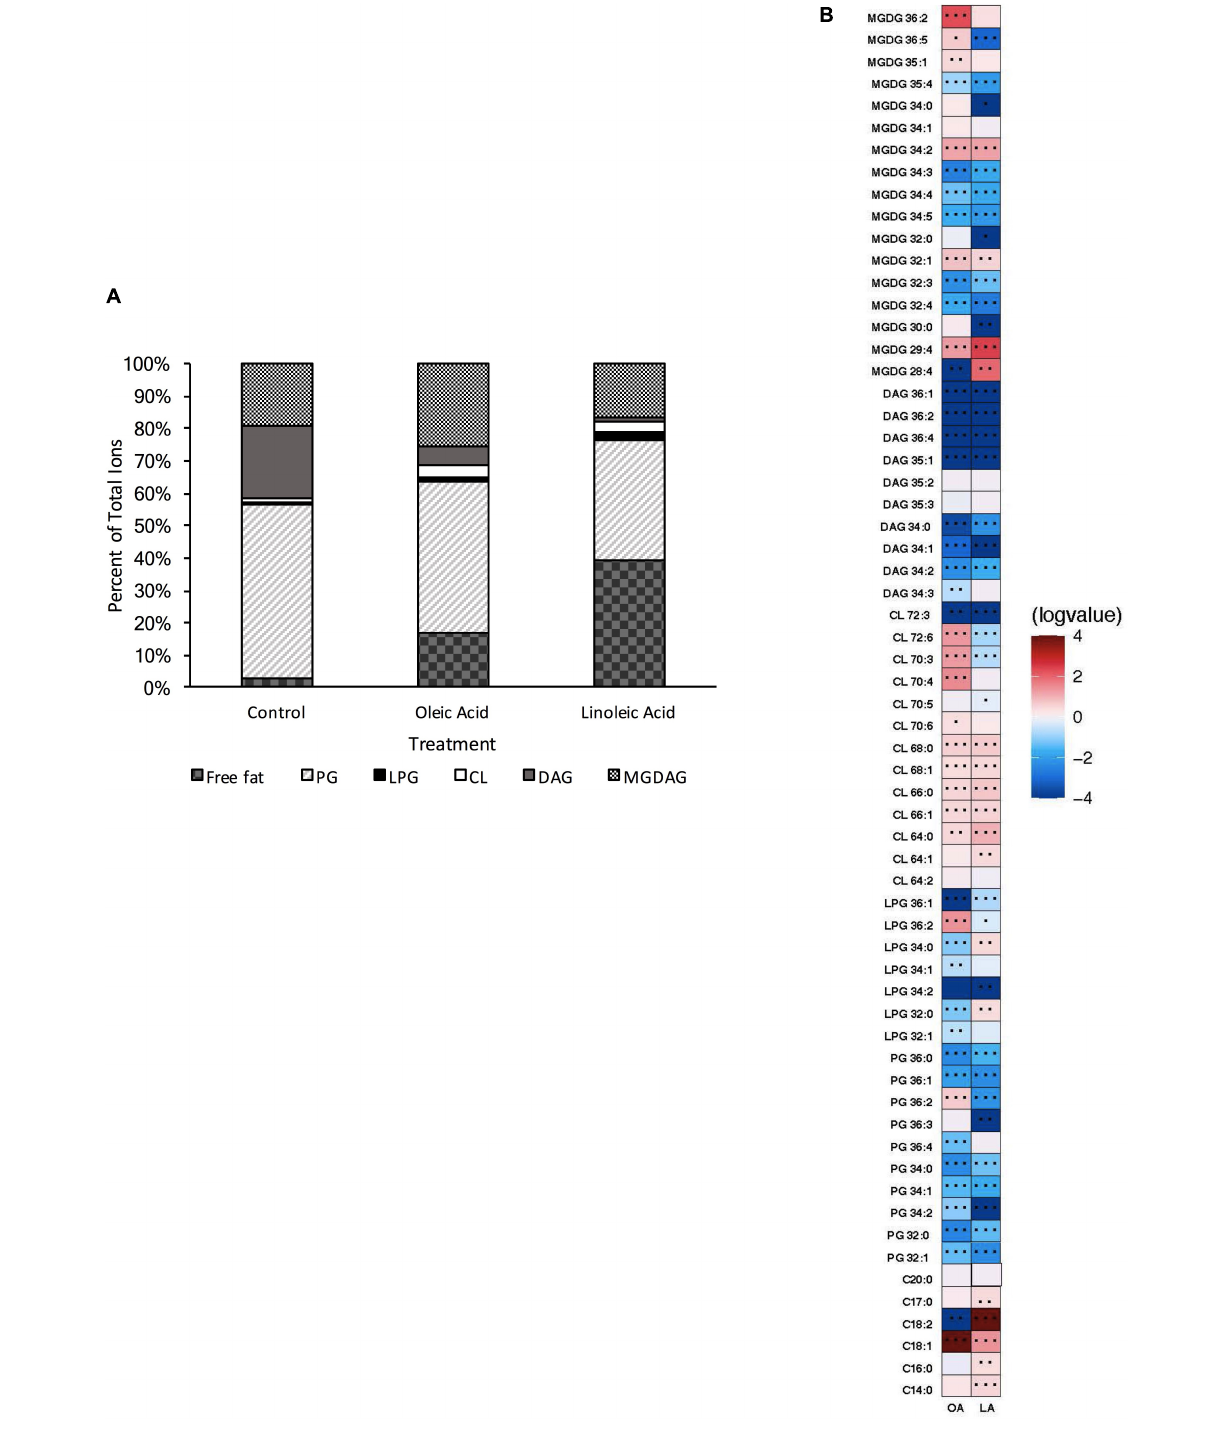
FIGURE 1 | Enterococcus faecalis OG1RF lipid composition is altered upon exposure to host fatty acids. (A) Percent totals of lipid species in solvent control: free fatty acids (2.7%), PG (53.7%), L-PG (1.1%), CL (1.1%), DAG (22.4%), and MGDG (19.0%), oleic acid: free fatty acids (16.8%), PG (46.7%), L-PG (1.5%), CL 3.3%), DAG (6.1%), and MGDG (25.6%), linoleic acid: free fatty acids (39.5%), PG (36.6%), L-PG (2.6%), CL (3.4%), DAG (1.4%), and MGDG (16.6%). Species were normalized to OD 600 nm . (B) Heat-map of fold changes upon fatty acid supplementation vs. solvent control; OA, oleic acid supplementation; LA, linoleic acid supplementation. Shown are the average fold changes of those detected lipid species above limit of detection for n = 5 samples. * P = 0.1–0.05; ** P = 0.05–0.01; *** P <